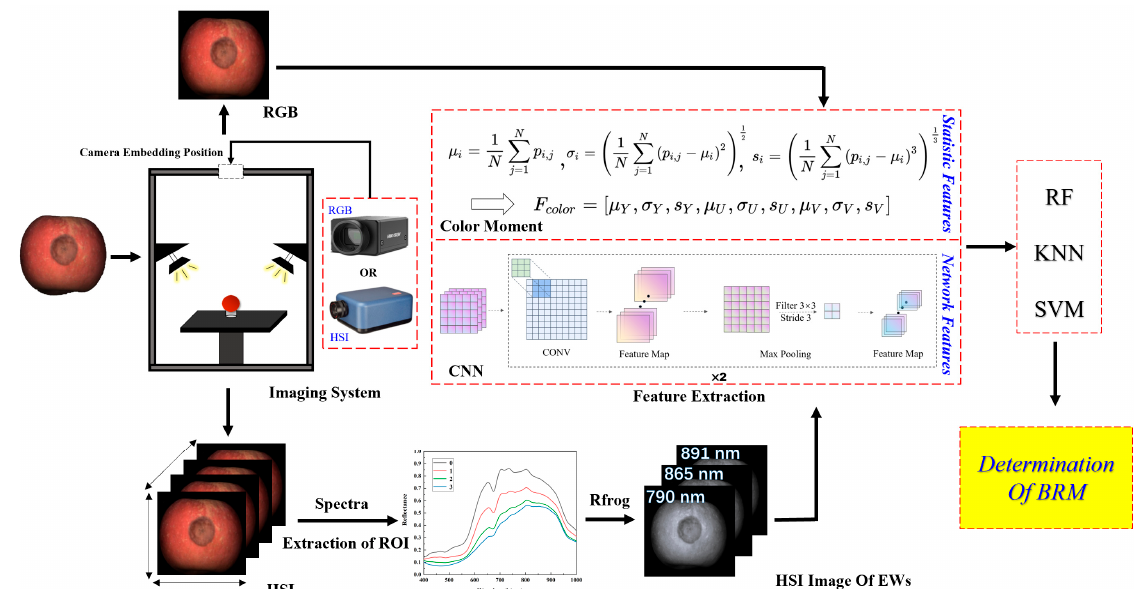
Figure 1. Flow chart of detection of BRM infection degree in apples. In the color moment, u i , σ i and s i represent the first-order moments, second-order moments and third-order moments of the image color, p ij represents the i-th color component of the j-th pixel of image, N represents the number of pixels in the image, and F color represents the histogram vectors including the first three orders of color moment for the three components (Y, U, V) of image, where Y denotes luminance, U and V denote chrominance.